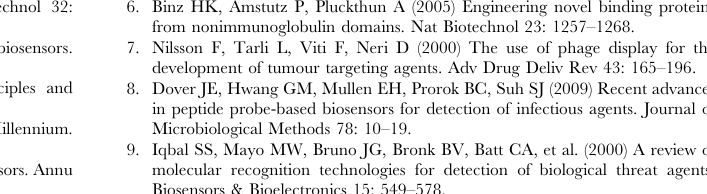
Table S1 Enrichments obtained by selecting the phage displayed peptide library over immobilized